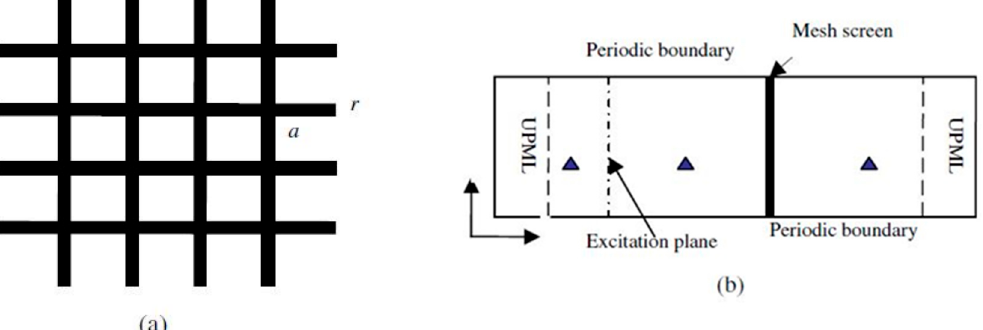
Figure 4. Two major models of wire mesh screens. ( a ) The physical model. ( b ) The numerical